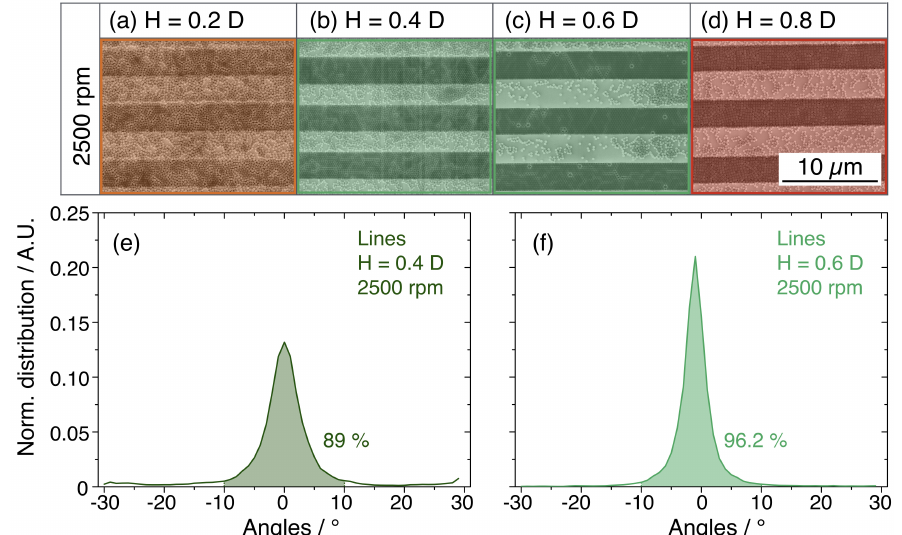
Figure 5. ( a – d ) SEM images of the NSs assemblies inside linear templates. The height of the constraining walls is varied from 0.2 to 0.8 times the diameter of the NSs across the images. ( e , f ) Line graphs reporting the normalised distribution of the domains orientation. The highlighted area corresponds to the percentage of domains aligned to the templates sidewalls within ±